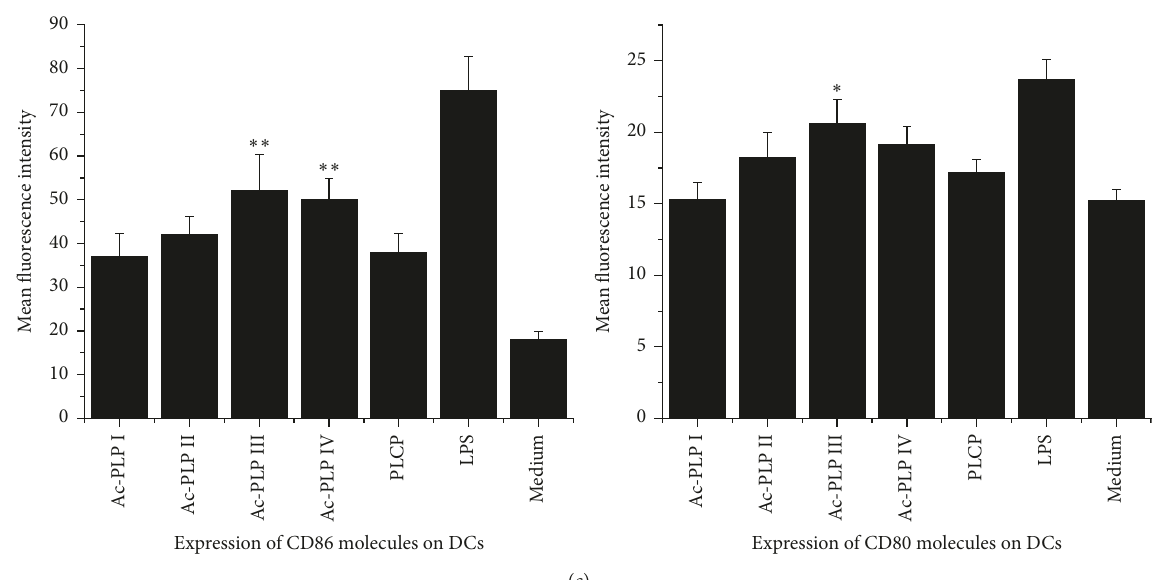
Figure 2: Ac-PLCP increased the expression of costimulating molecules on DC. DCs treated with Ac-PLCPs III and IV expressed a higher level of CD86 (a) and CD80 (b) molecules than PLCP group. The results shown were from one representative experiment of three independent experiments performed. ∗ 𝑃 < 0.05 compared to the PLCP group; ∗∗ 𝑃 < 0.01 compared to the PLCP group.